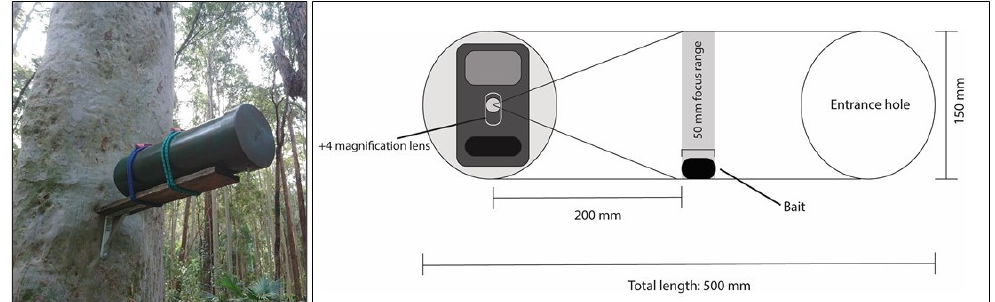
Figure 3. Example of a selfie trap positioned 2m off the ground to target arboreal species. Inside is a camera with an altered focal distance for close recording of small mammal species.